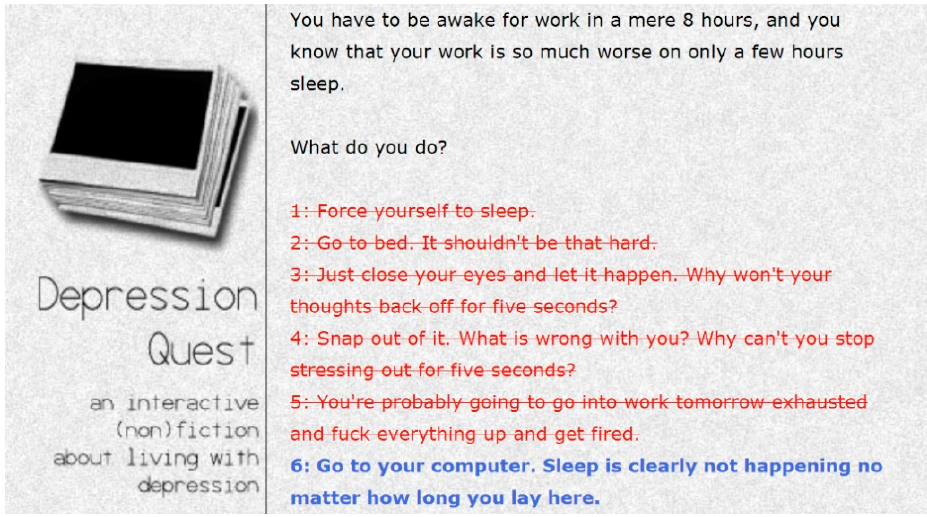
Figure 3. Depression Quest steadily eliminates options as the game unfolds.